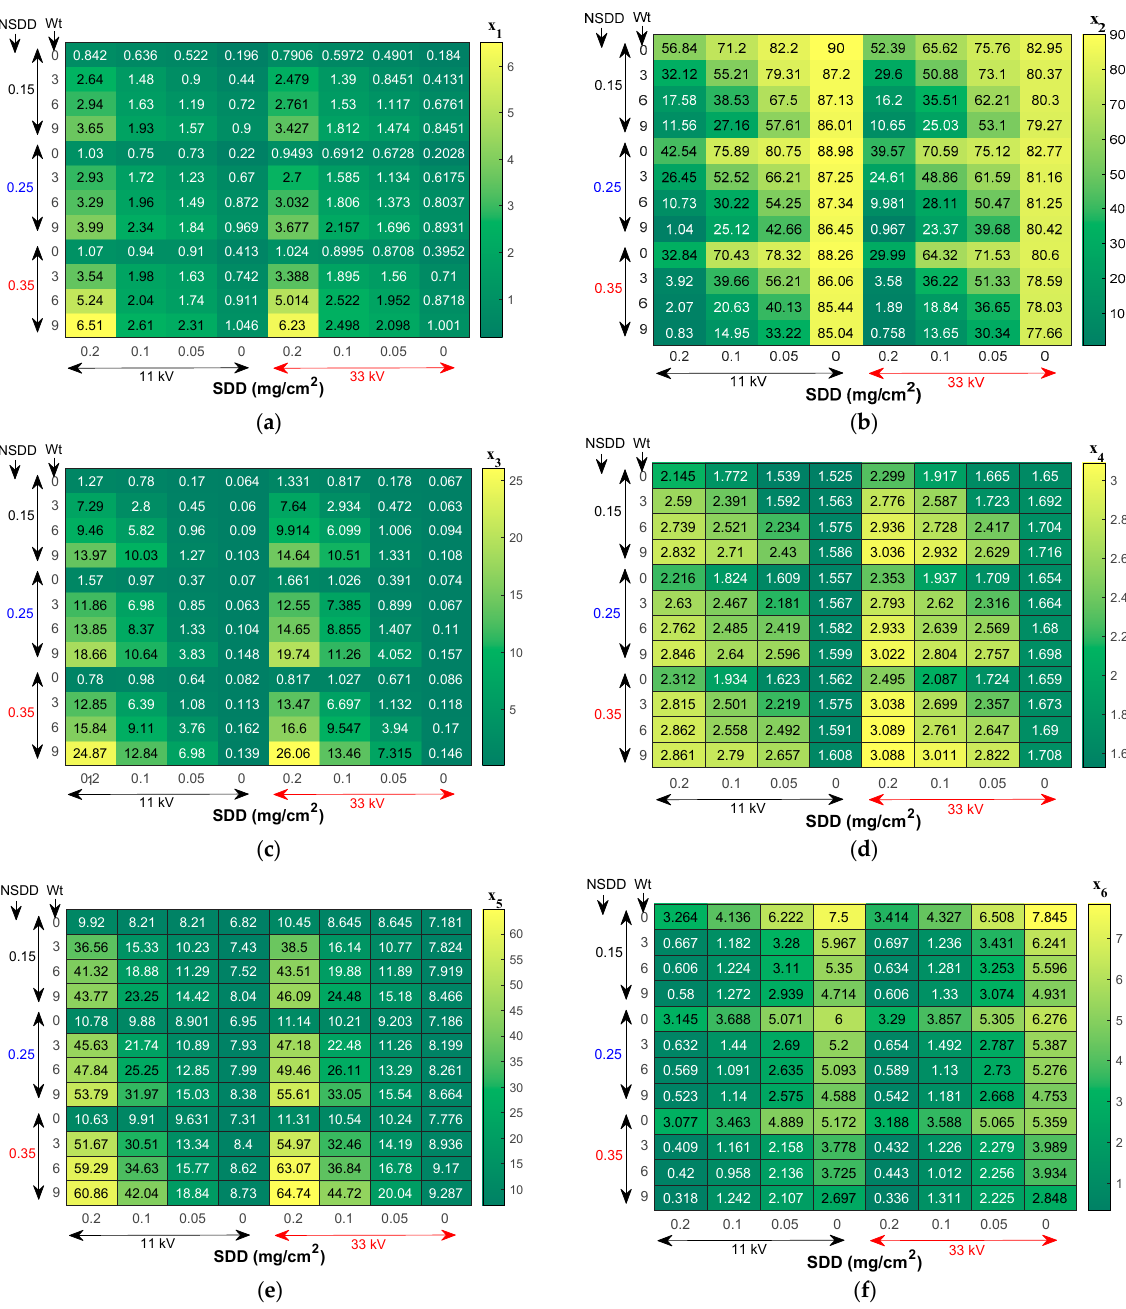
Figure 11. The impact of NSDD on indicator shift. 5.2.3. Indicator Trends under Different Wt The relationship between the proposed indices x 1 –x 6 and Wt for porcelain insulator under SDD of 0.2 mg/cm 2 , NSDD of 0.35 mg/cm 2 , and Pu/PL of 1/1 and different Wt is demonstrated in Figure 12. It is worth noting that when Wt increases, the x 2 and x 6 fall while the x 1 , x 3 , x 4 , and x 5 increase. For example, under SDD of 0.2 mg/cm 2 , NSDD of 0.35 mg/cm 2 , and P u /P L of 1/1, the x 1 increased by 13.4% and 15.4% when Wt increased from 3 to 6 mL/h and from 3 to 9 mL/h, respectively, whereas under the same conditions, the x 2 decreased by 72.1% and 57.2% when Wt increased from 3 to 6 mL/h and from 6 to 9 mL/h, respectively.